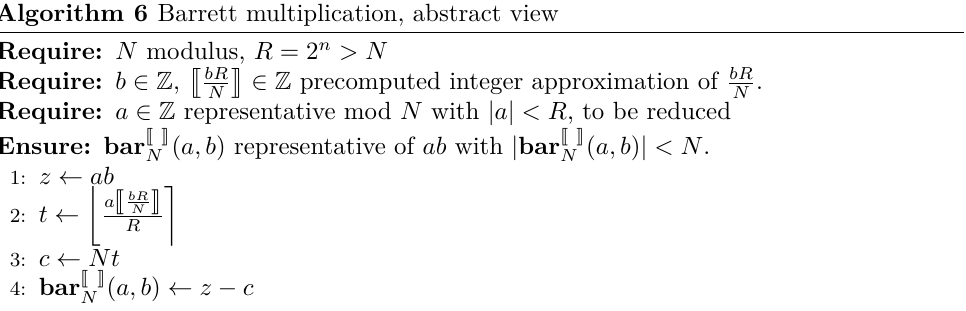
Algorithm 6 Barrett multiplication, abstract